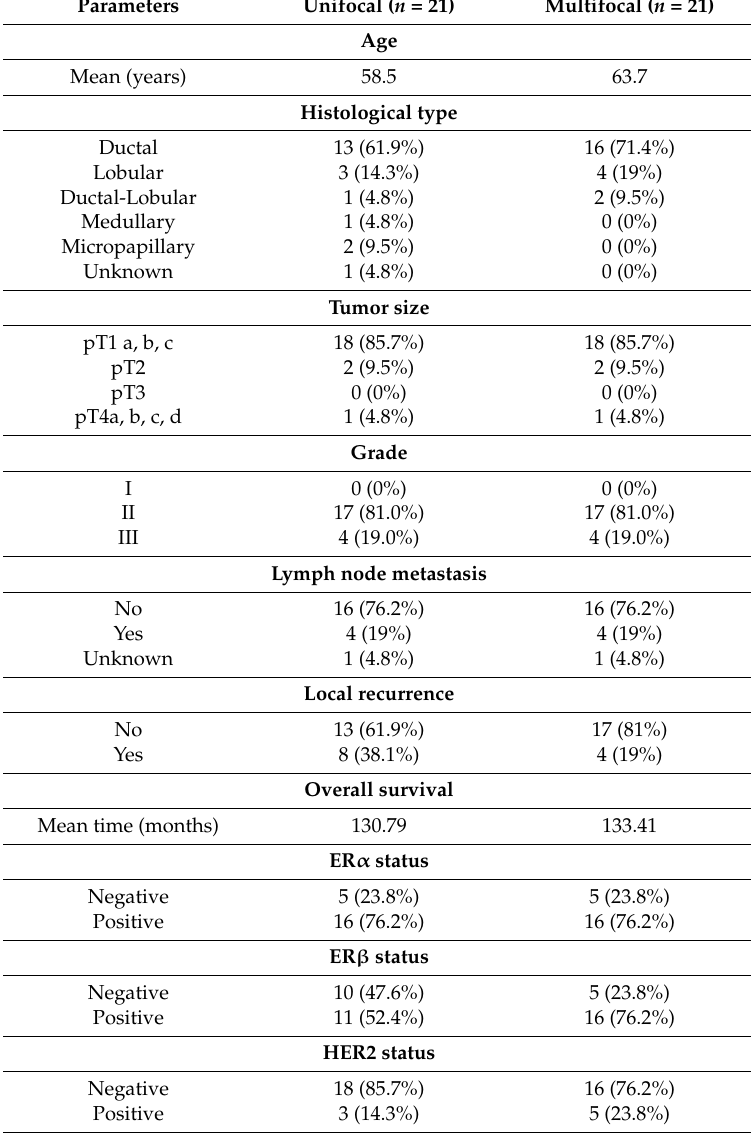
Table 1. Clinicopathological features of the matched-pair